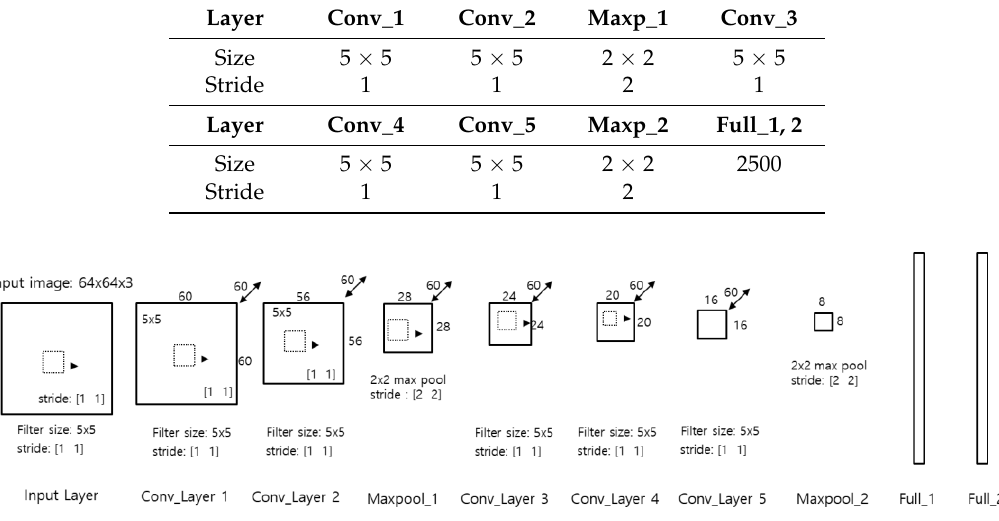
Figure 2. Proposed CNN Model.